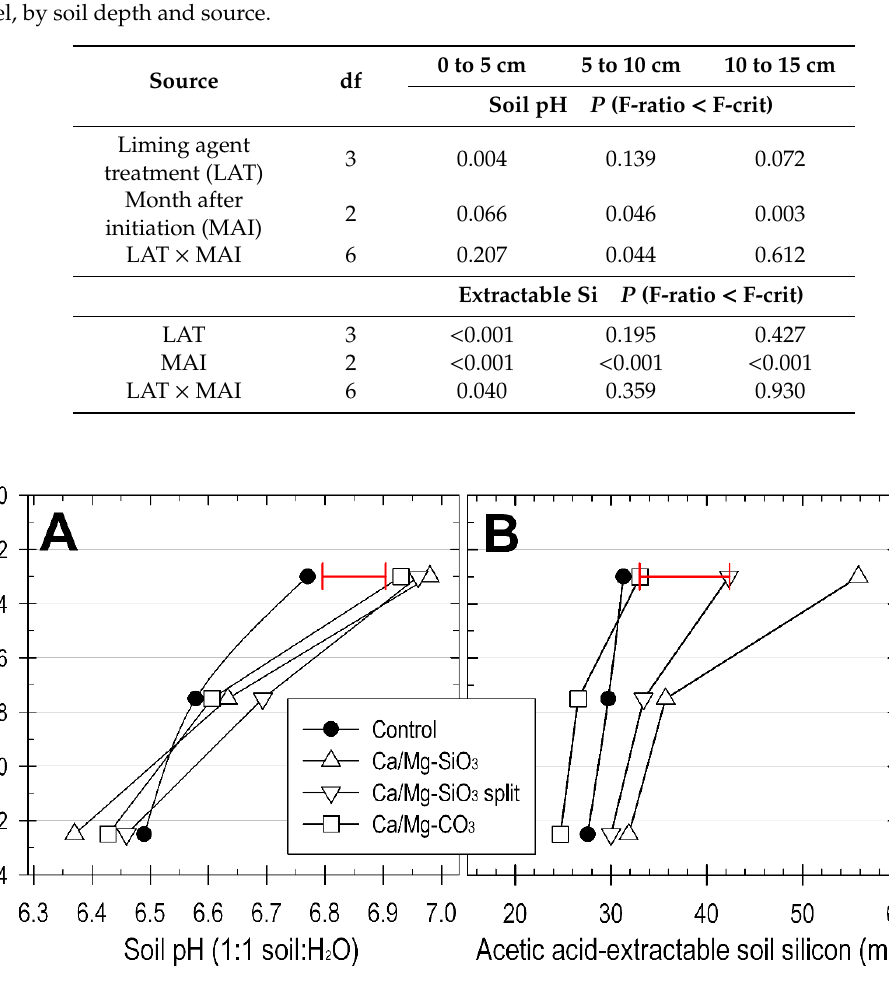
Figure 2. ( A ) Creeping bentgrass fairway mean soil pH (1:1) by liming agent treatment and sample depth. ( B ) Mean acetic-acid (0.5 M) extractable soil silicon by liming agent and sample depth. For soil chemical property at depth(s) indicated, error bars show least significant difference (alpha = 0.05) between treatment means.